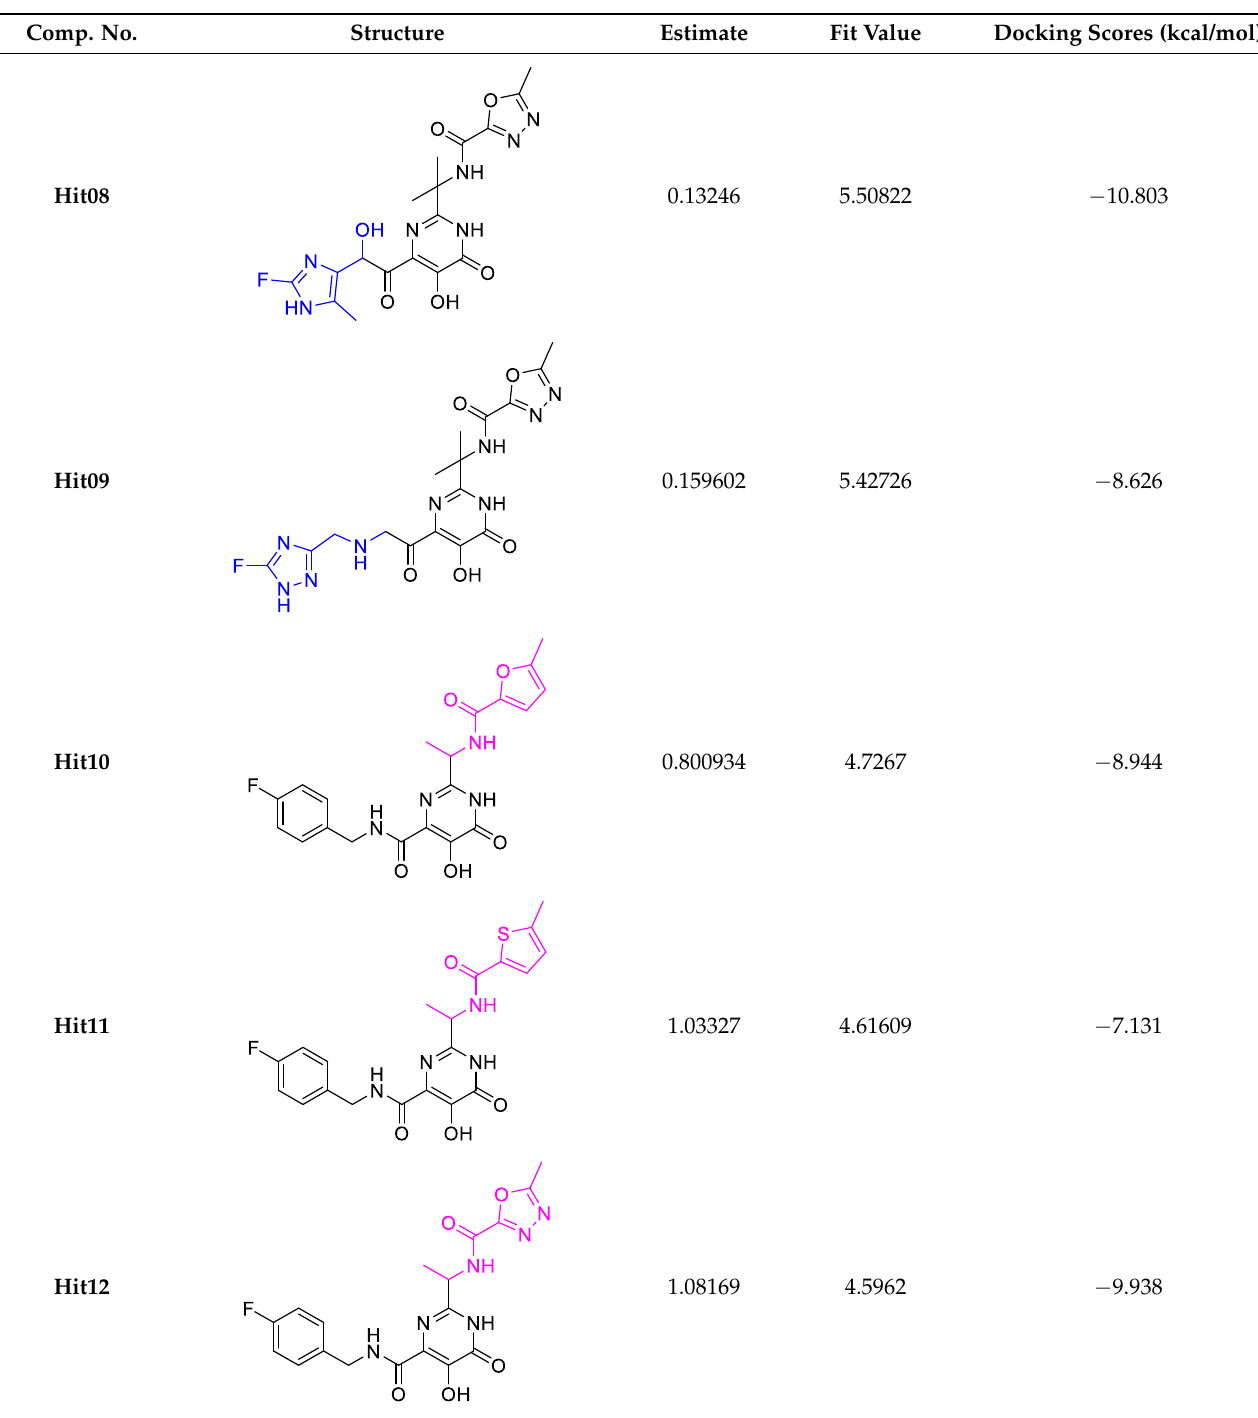
The docking scores of selected candidate compounds ( Hit07 – Hit09 and Hit10 – Hit12 ) were lower than Hit01 , except Hit07 and Hit11 . Furthermore, the estimated activity values of all compounds were more declined than Hit01 (estimated activity value was 1.16424 µ M) based on the prediction results. Table 7 enlisted the structures of the six raltegravir’s derivatives selected after Lead optimization and molecular docking. The functional groups were circled in blue and pink after Lead optimization and the control compound remained unchanged. It was noticeable that the six potent compounds which had good results